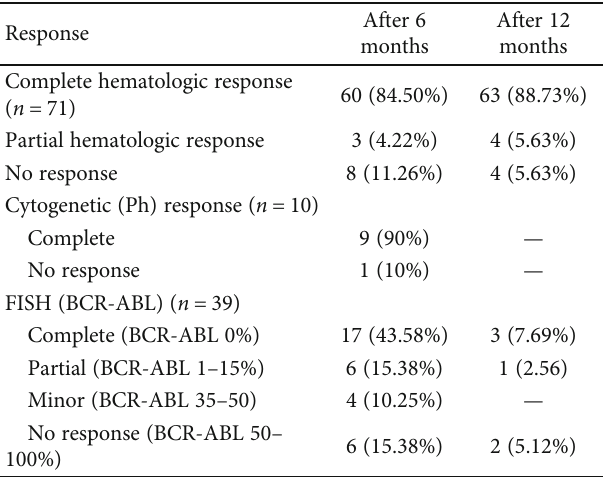
Table 6: Results of CML patients who responded to imatinib mesylate treatment.